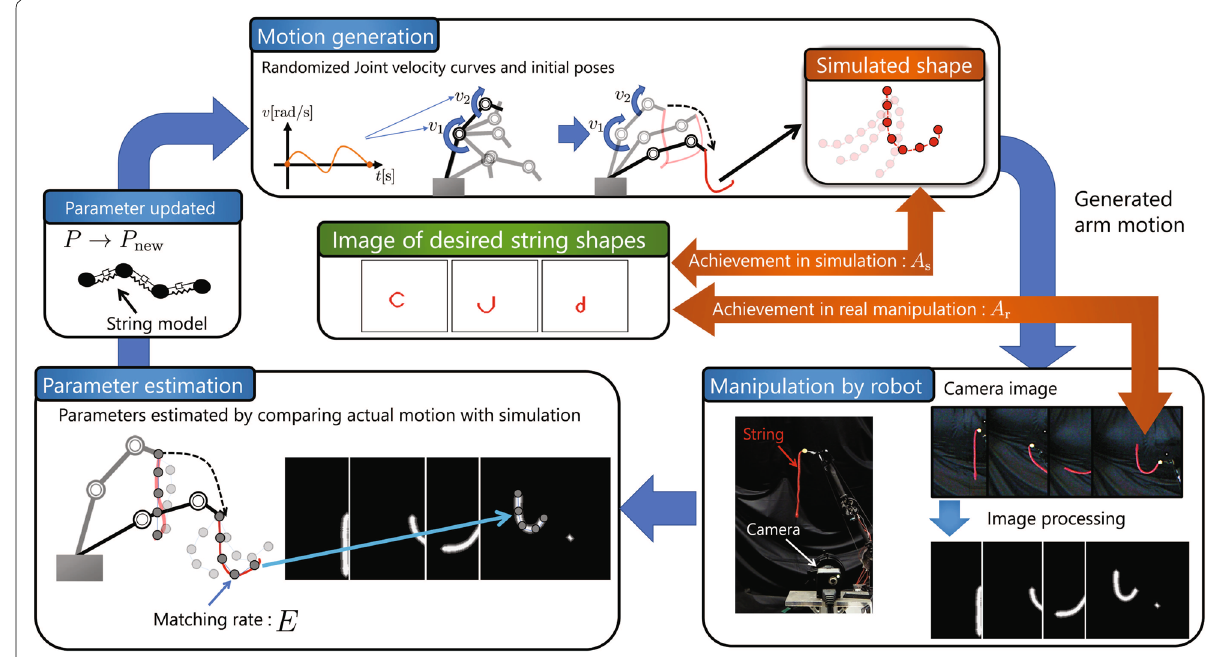
Fig. 1 Concept of dynamic manipulation for unknown